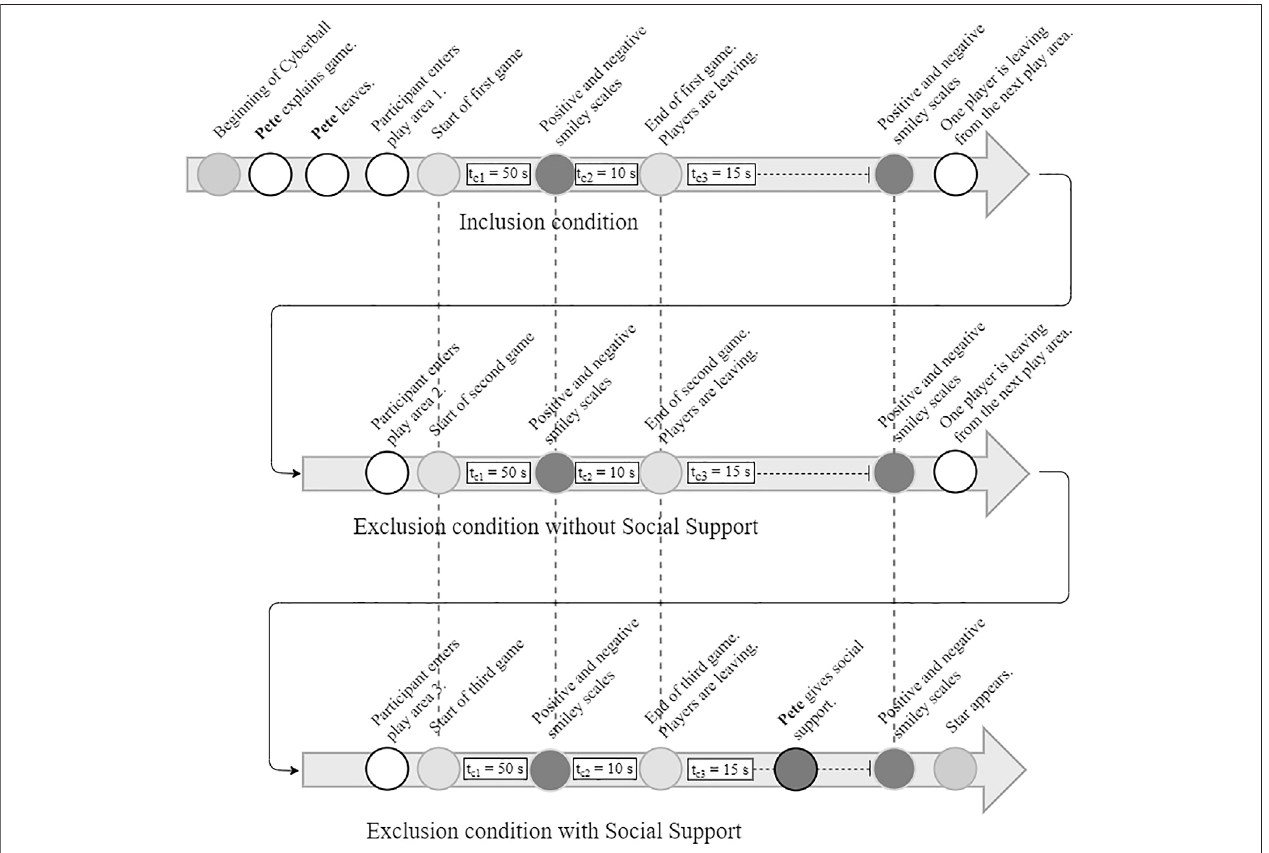
FIGURE 8 | Sequence of the Cyberball scenario with the three conditions in a set